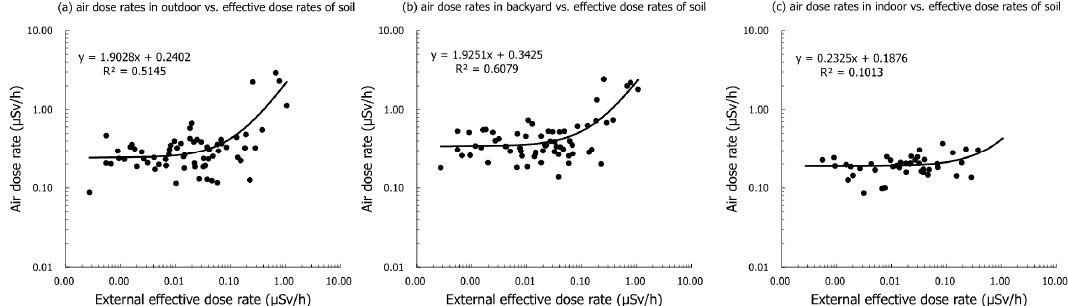
Figure 2. Relationship between estimated external effective dose rates from surface soil and air dose rates in Tomioka town. ( a ) Air dose rates in outdoor (entrance) vs., ( b ) air dose rates in outdoors (backyard) vs. and ( c ) air dose rates in indoor (entrance) vs. effective dose rates of soil samples. The external effective dose rates from soil samples were estimated using a high purity germanium detector (only radiocesium). Air dose rates were measured at the sampling points using a NaI (Tl) scintillation survey meter (natural dose rates including radiocesium).